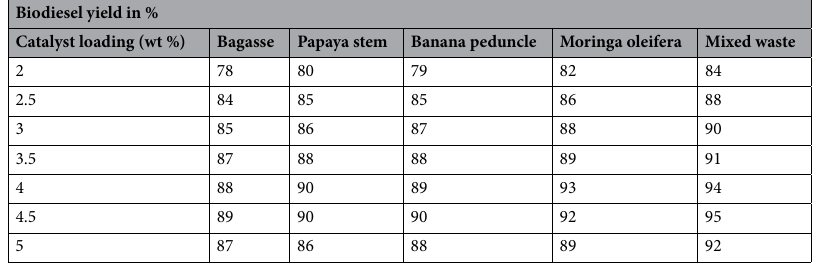
Table 4. Catalyst loading (wt %) effects on biodiesel